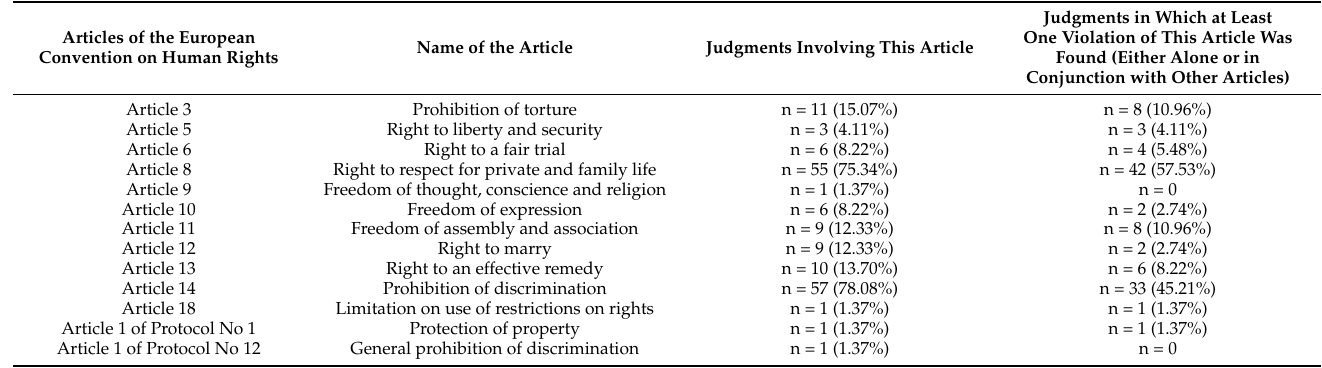
Table 1. Frequencies of articles on rights and freedom (Section 1, Articles 1–18) and protocols of the European Convention on Human Rights in the n = 70 judgments included in this